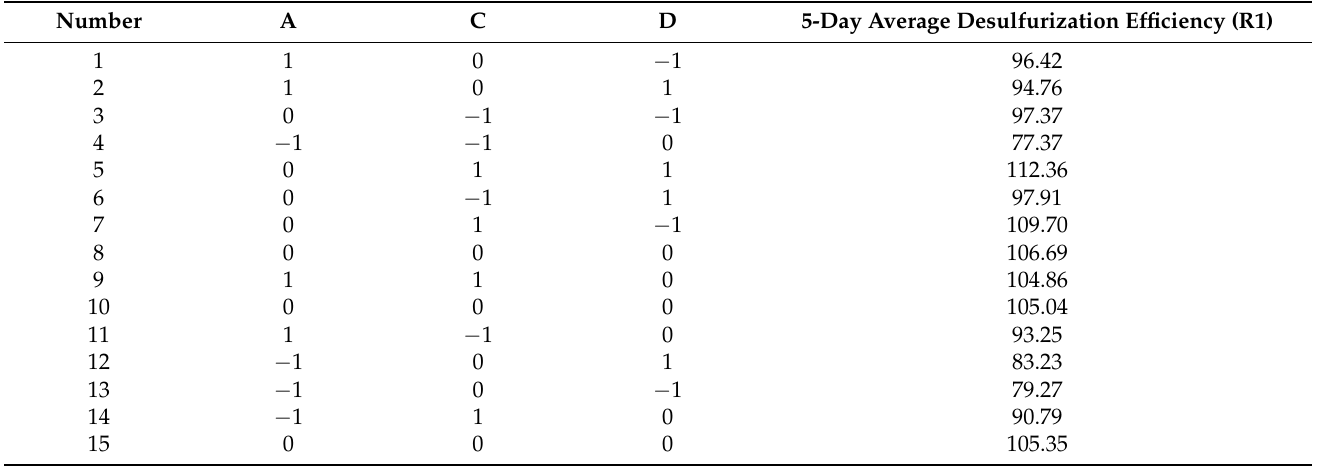
Table 6. Experimental conditions of Box–Behnken design for